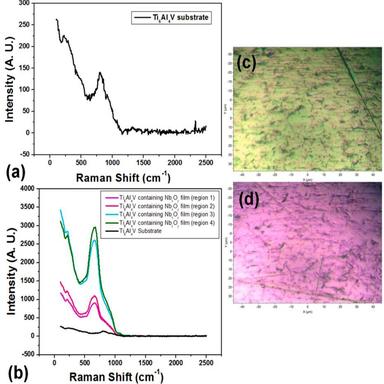
(a) Raman spectrum of the Ti6Al4V alloy, (b) Raman spectrum of the Ti6Al4V coated with Nb2O5 thin film, (c) and (d) show two different regions (green and pink) where Raman measurements were taken. The measured regions were not shown in the figure (c) and (d), respectively.